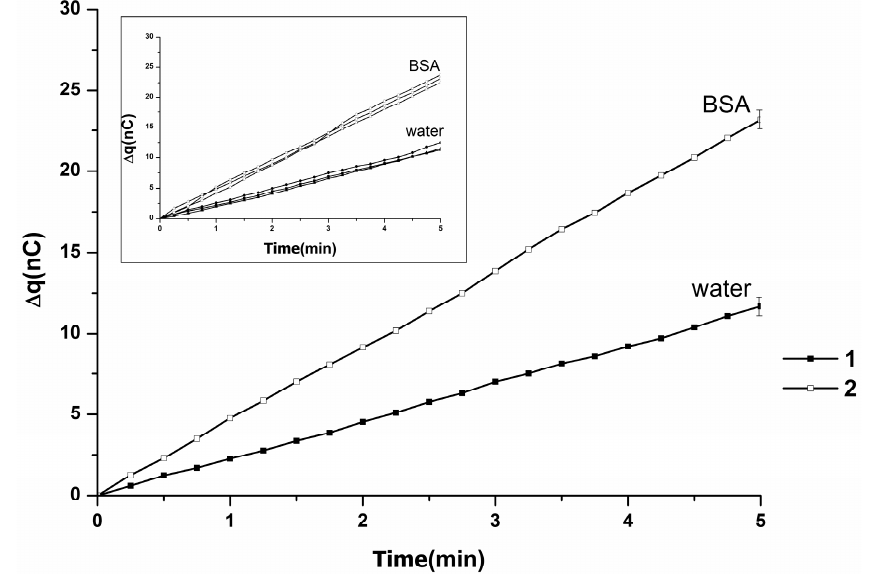
Figure 9. The effect of the presence of bovine serum albumin (BSA) protein on the charge generation in water. Averaged ∆ q(t) dependencies obtained upon flow of water through the injector nozzle in the absence and in the presence of 10 − 15 M BSA. Main graph presents averaged Δ q(t) dependencies obtained in a series of experiments: ( 1 ) without BSA ( 2 ) with BSA. Inset displays typical Δ q(t) dependencies obtained in a series of experiments upon pumping of water through the injector. Experimental conditions: ( 1 ) without BSA (“water”); ( 2 ) with BSA (“BSA”). T = 35 °C. The data of one and the same set of experiments obtained using one and the same tube ‐ pipe ‐ tip set (see the Materials and Methods section) are presented.